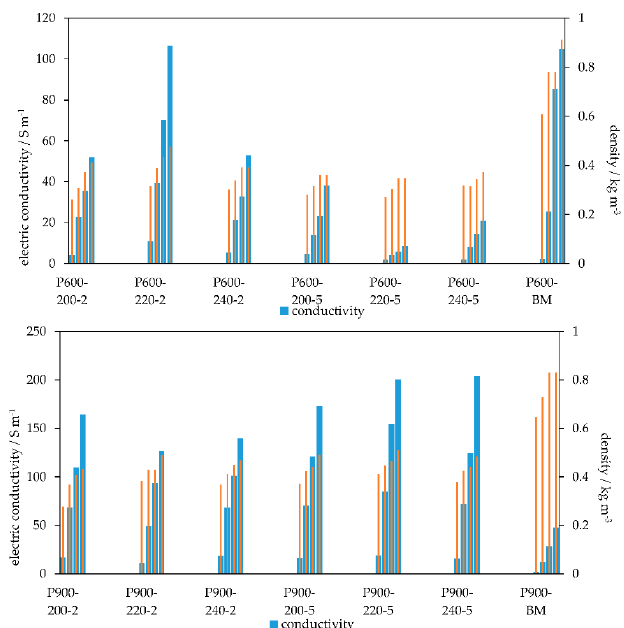
Figure 7. Electric conductivity (±max. 10 S m − 1 ) and bulk density (standard deviation 0.01 g cm − 3 ) of the PHC600 ( top ) and the PHC900 ( bottom ) samples. For each char, four levels of compression with the weights 0.199 kg; 2.199 kg; 5.199 kg, and 10.199 kg (from left to right) are shown.